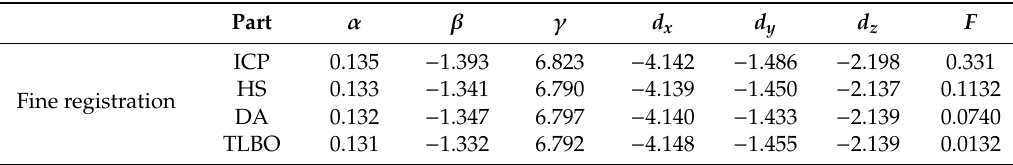
processor was an i5-4200U CPU @